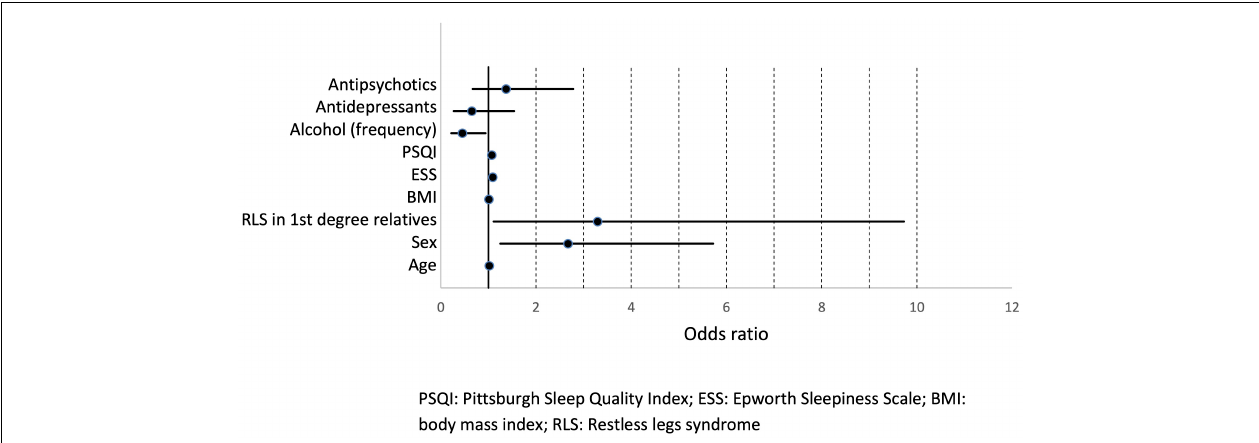
FIGURE 2 | Odds ratios with 95% confidence intervals. PSQI, Pittsburgh Sleep Quality Index; ESS, Epworth Sleepiness Scale; BMI, body mass index; RLS, restless legs